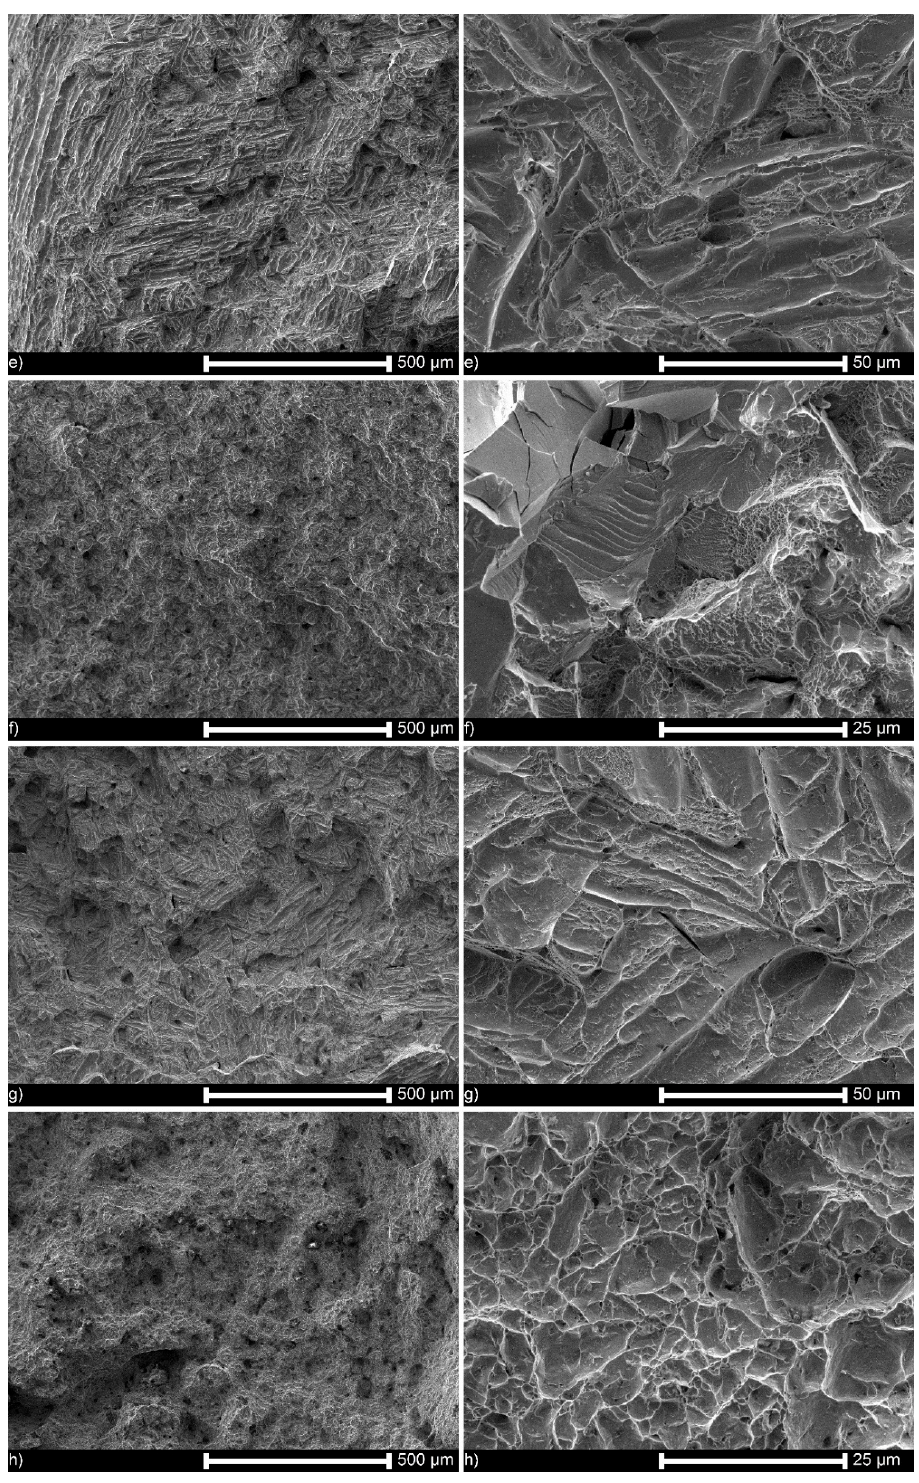
Figure 8. Fracture faces of specimens: ( a ) oxidized at 350 ◦ C, and simultaneously hydrogen charged and tensed, ( b ) oxidized at 350 ◦ C, hydrogen charged and tensed, ( c ) oxidized at 700 ◦ C, hydrogen charged and tensed, ( d ) oxidized at 700 ◦ C and 1000 ◦ C, and tensed,( e ) oxidized at 700 ◦ C and at 1000 ◦ C, hydrogen charged and tensed, ( f ) oxidized at 900 ◦ C and tensed, ( g ) oxidized at 900 ◦ C, hydrogen charged and tensed, ( h ) oxidized at 350 ◦ C and tensed (reference